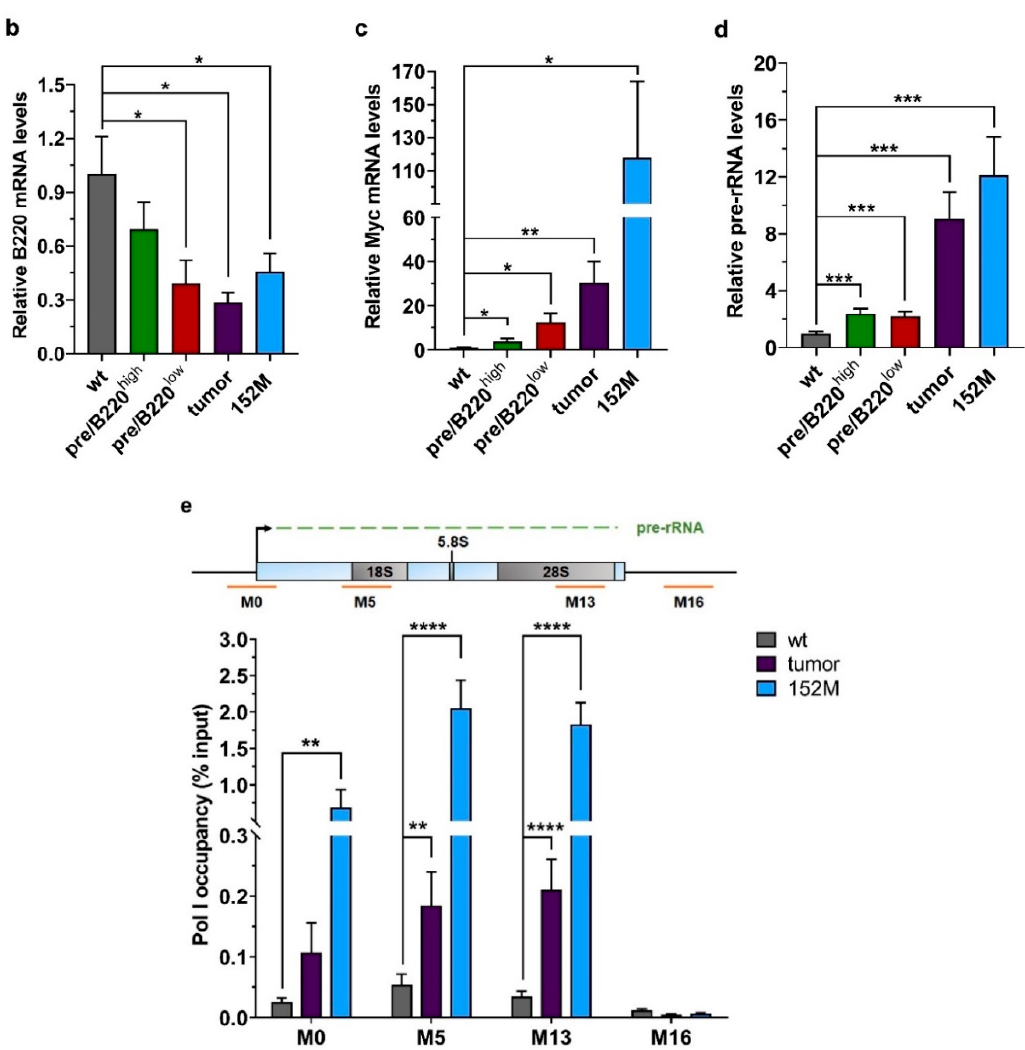
Figure 1. Up-regulation of Pol I transcription in Myc-driven lymphomagenesis. ( a ) Representative FACS plots of B cells isolated from wt mice (left) or pre-tumoral (middle) and tumoral (right) E µ - Myc mice. Populations used for further analysis are boxed. ( b – d ) Expression of B220 , Myc and rRNA genes in primary B cells from wt and Eµ- Myc mice as well as in the Eµ- Myc lymphoma cell line 152M. Transcript levels were measured after reverse transcription by qPCR and normalized to B2M mRNA levels. ( e ) Occupancy of the Pol I subunit RPA116 at rDNA in wt, tumor, and 152M cells. ChIP was followed by qPCR using rDNA amplicons indicated in the scheme above and enrichment was calculated relative to input. Statistical analysis was performed using two-way ANOVA with Tukey multiple comparison test. Data in ( b – e ) represent mean values ± SEM from at least three biological replicates. * p < 0.05, ** p < 0.01, *** p < 0.001, and **** p < 0.0001.